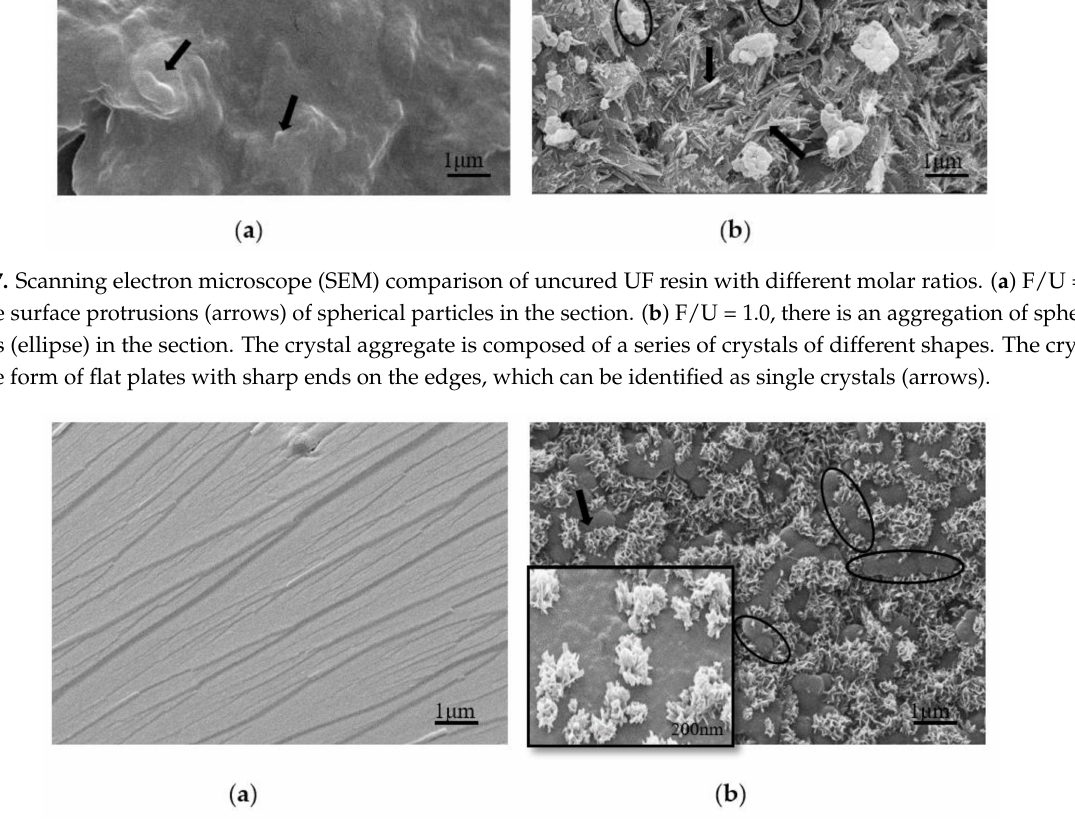
Figure 8. SEM comparison of cured UF resins (no curing agent added) with different molar ratios. ( a ) F/U = 1.4, ( b ) F/U = 1.0, a large number of spherical particles appeared on the section, and some spherical particles were clustered in the form of beads (ellipse), surrounded by many snowflake-shaped primary particles (arrows) composed of flat plates and filamentous crystals. Illustration: High magnification view at the arrow in the upper left corner of the